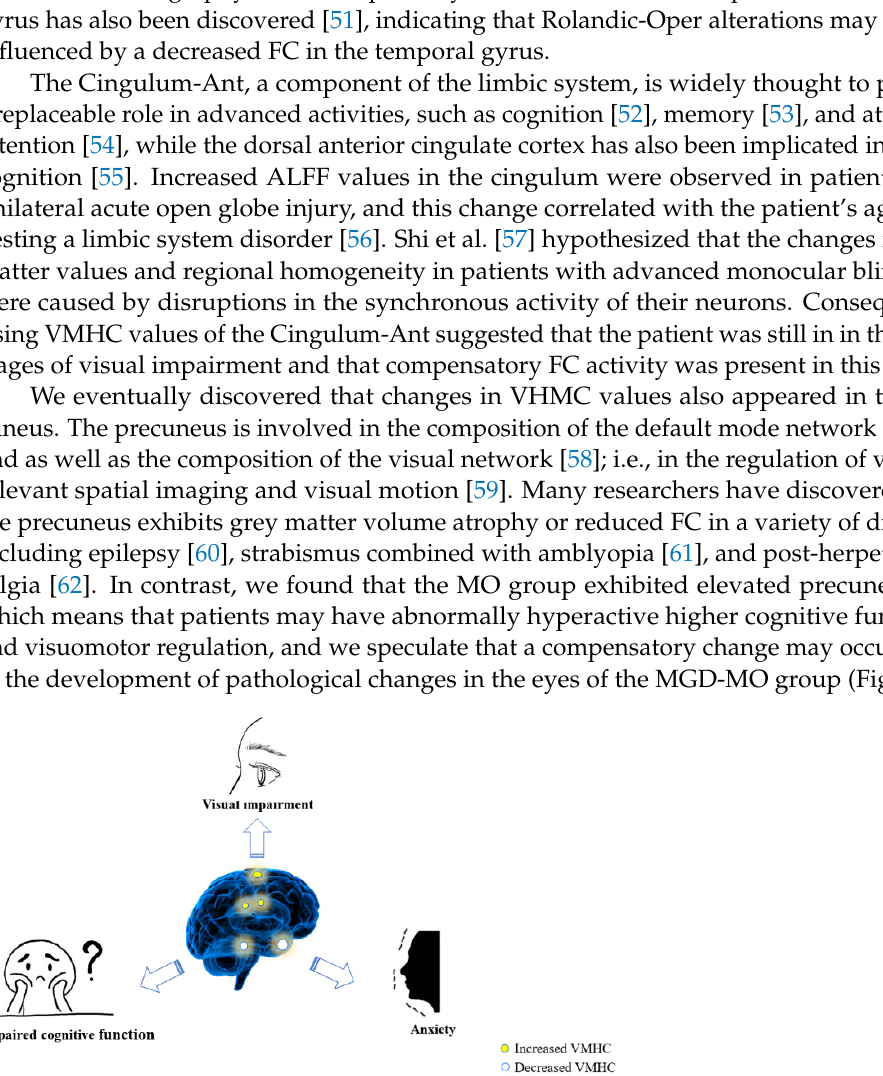
Figure 7. The association between abnormal activity in brain areas and clinical presentation. Notes: Patients exhibit altered VMHC values in specific brain regions that may be associated with a tendency to anxiety, impaired visual acuity, and lower MMSE score.